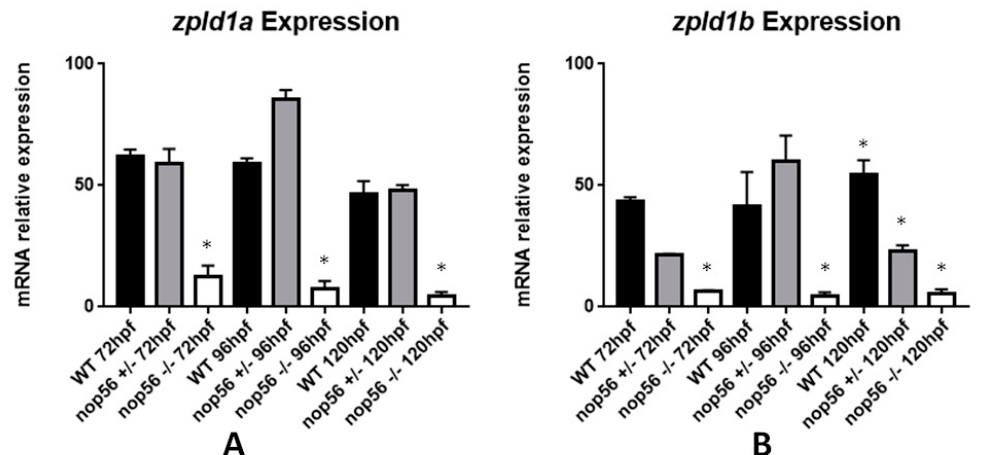
Figure 11. Graphic representation of expression analysis by RT-qPCR. ( A ) Zpld1a expression is significantly reduced in nop56 − / − larvae between 72 and 120 hpf ( p -value < 0.0001). ( B ) Zpld1a expression is significantly reduced in nop56 − / − larvae between 72 and 120 hpf ( p -value < 0.0001) and in nop56 +/ − at 120 hpf. Statistically significant data in the graphs are indicated with a